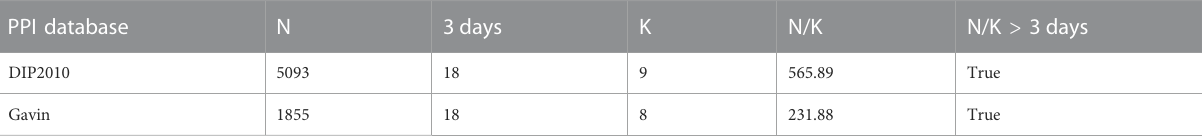
TABLE 1 Values of K in different